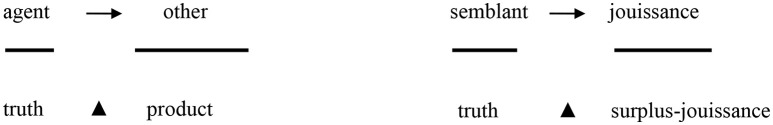
Overall structure of the discourses that Lacan discerns, including the non-rapport at the basis of the relationship between agent/semblant and other/jouissance (based on: Lacan, 1969–1970, p. 151).